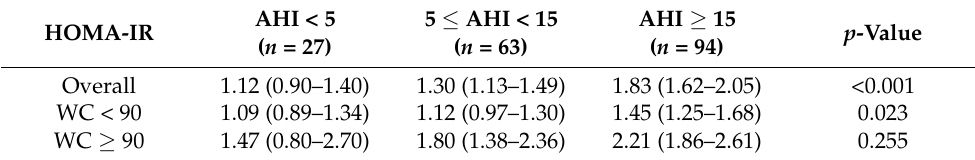
Table 3. HOMA-IR (95% confidence interval) according to OSA